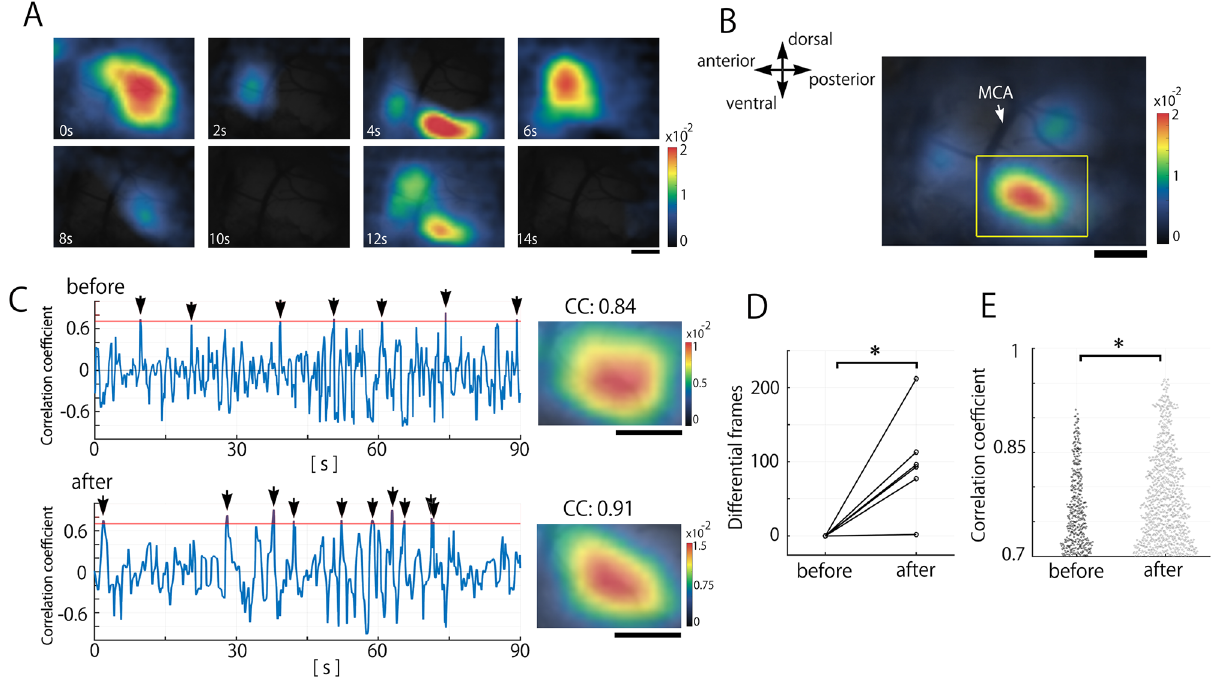
Figure 2. Effects of repeated electrical stimulation of the PDL on spontaneously emerging cortical activity. ( A ) Examples of spontaneous activity in the session before PDL stimulation, showing various activation patterns. ( B ) An example of the template image evoked by PDL stimulation. For spatial correlation analysis, the rectangular area was set to detect IC activity. ( C ) Time courses of spatial correlation coefficients (CC) between the template and each spontaneous frame in the session before (upper) and after (bottom) PDL stimulation. The threshold is set at the mean CC + 2 SD determined by the imaging session before the PDL stimulation (red horizontal lines). Arrowheads indicate the events over the threshold. Spontaneous patterns with maximum CC over the threshold are shown in the right column. Spontaneous activities over the threshold are observed in the sessions before and after PDL stimulation. ( D ) The number of frames that exhibited a CC larger than the threshold in the session after PDL stimulation was greater than that in the session before PDL stimulation (Wilcoxon signed-rank test; * p = 0.031). ( E ) Comparison of the CC of the frames that exhibited a larger CC than the threshold. PDL stimulation significantly augmented the CC (Mann–Whitney U test; *** p < 0.001). Scale bars in ( A )–( C ) indicate 500